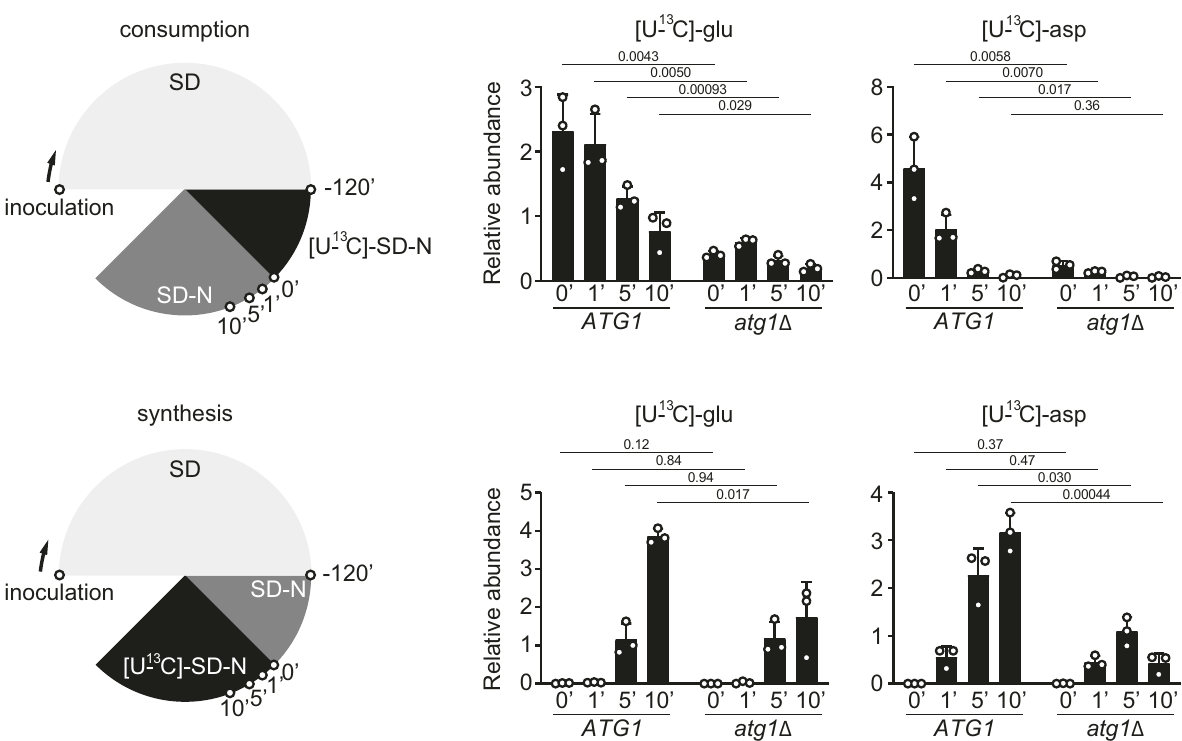
Fig. 3 Autophagy promotes glutamate and aspartate synthesis under nitrogen starvation. a Glutamate and aspartate are consumed at comparable rates in WT ( ATG1 ) and atg1 Δ cells under nitrogen starvation. Three independent replicates. b Glutamate and aspartate accumulate more rapidly in WT cells under nitrogen starvation. Three independent replicates. P values were calculated using unpaired two-sided Student ’ s t test assuming equal variances. Data are presented as mean ± standard